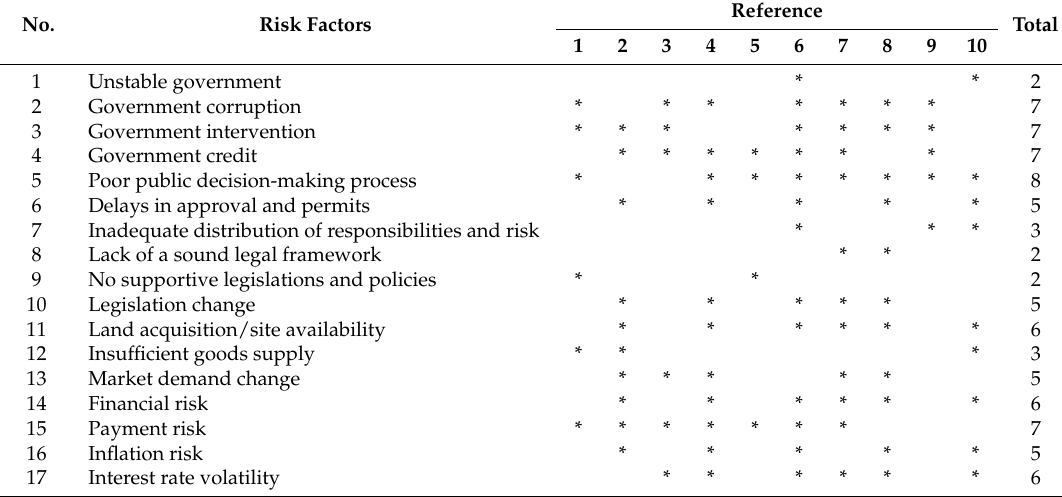
Table 1. Summary of selected literature on risks/barriers to public–private partnership (PPP) infrastructure